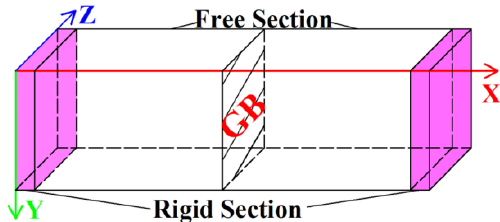
Figure 5. Schematic illustration of the bicrystalline model. The pink sections are rigid sections. Table 2. Detailed model parameters of the bicrystalline model.